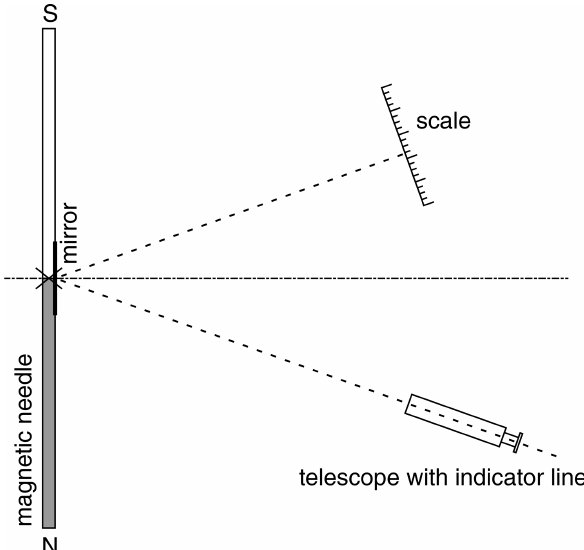
Figure 4. The top view of the bifilar magnetometer, mirror, tele- scope, and